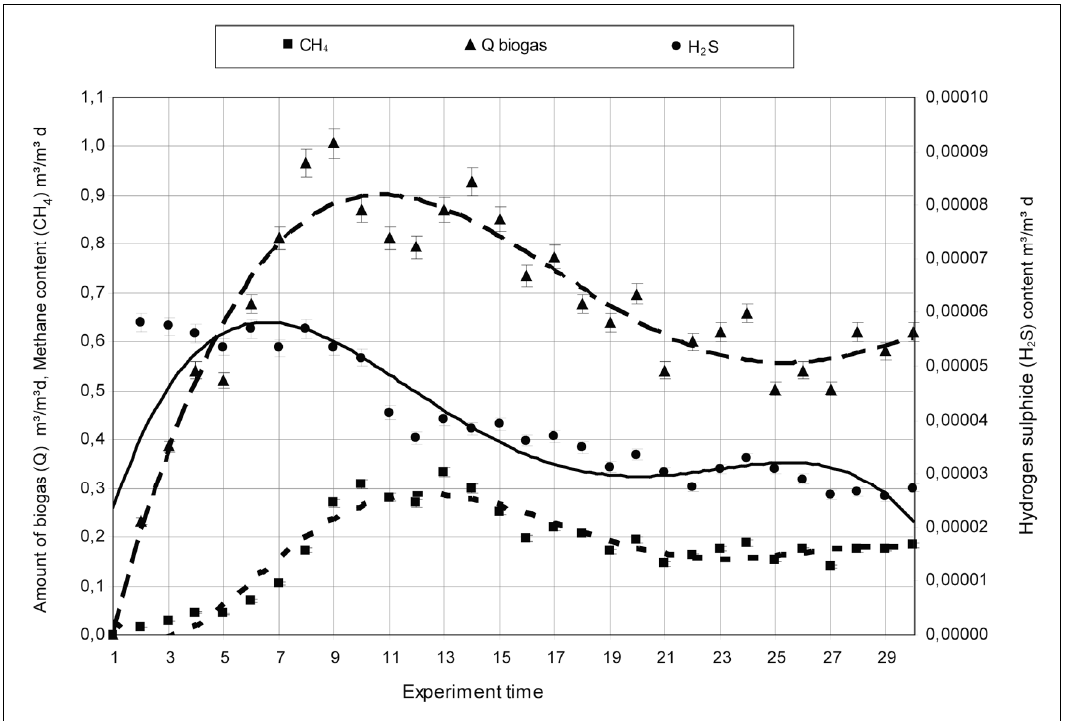
3 3 3 3 /m d), methane (m /m d) and hydrogen sulphide (m